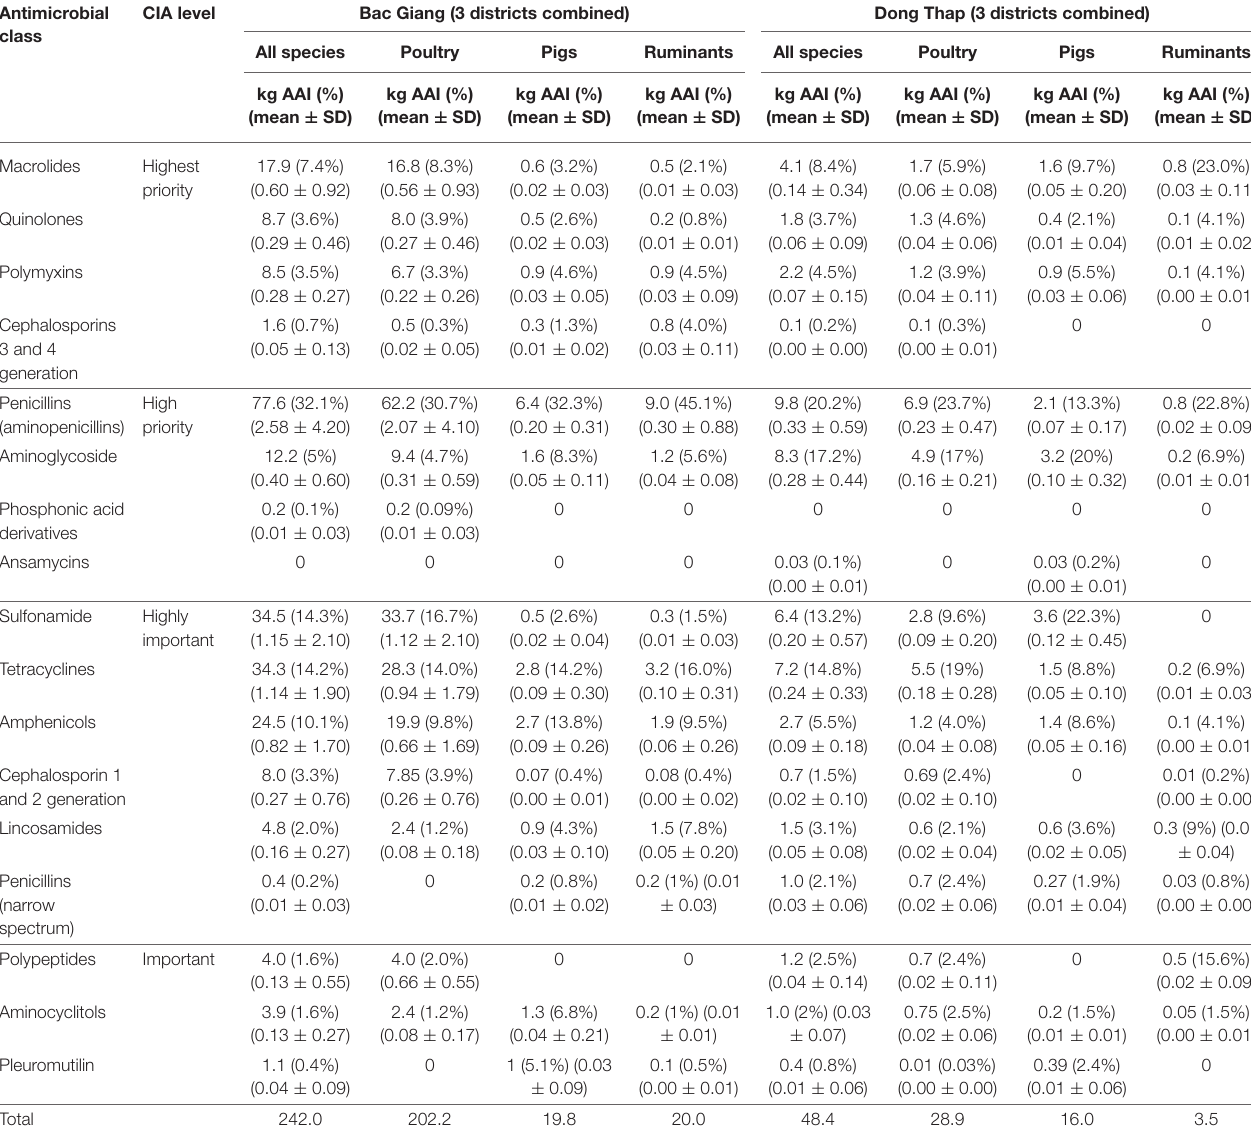
TABLE 2 | Total antimicrobial sales in the 3-week observation period in study districts. Antimicrobial